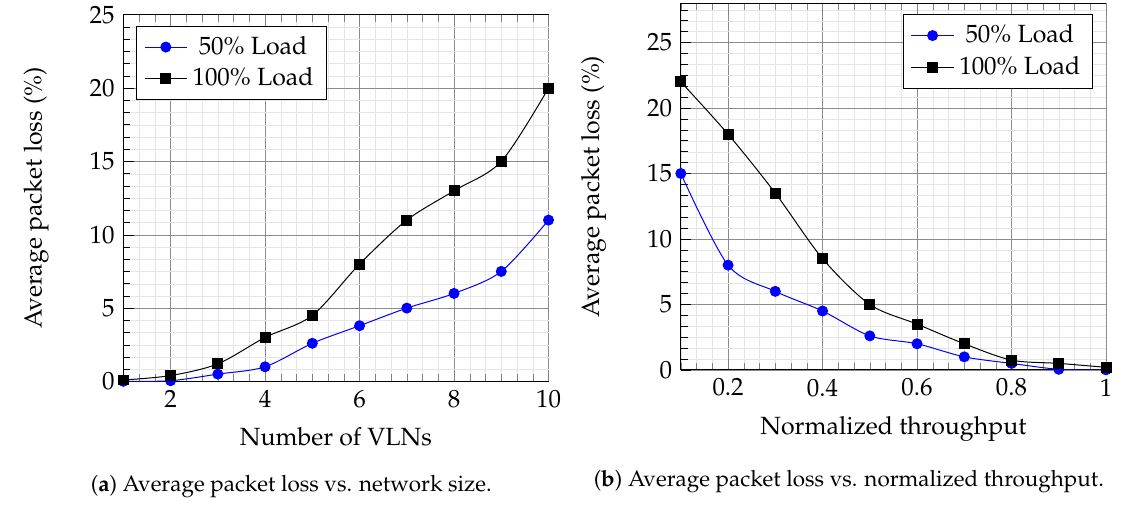
Figure 6. Average packet loss vs. network size and network load.